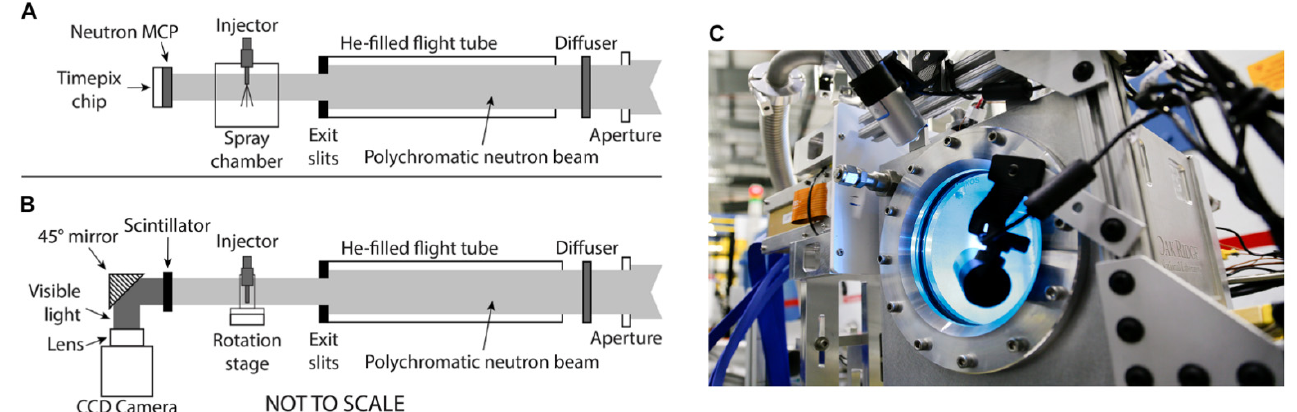
Figure 1. Experimental setups for high-speed neutron imaging and neutron CT. Beam travels from right to left in all panels. ( A ) High-speed setup uses the MCP detector with a custom sample environment that includes the injector and spray chamber. ( B ) Tomography setup uses the CCD detector with injector mounted on a rotation stage. ( C ) Photo of aluminum spray chamber mounted in front of MCP detector.